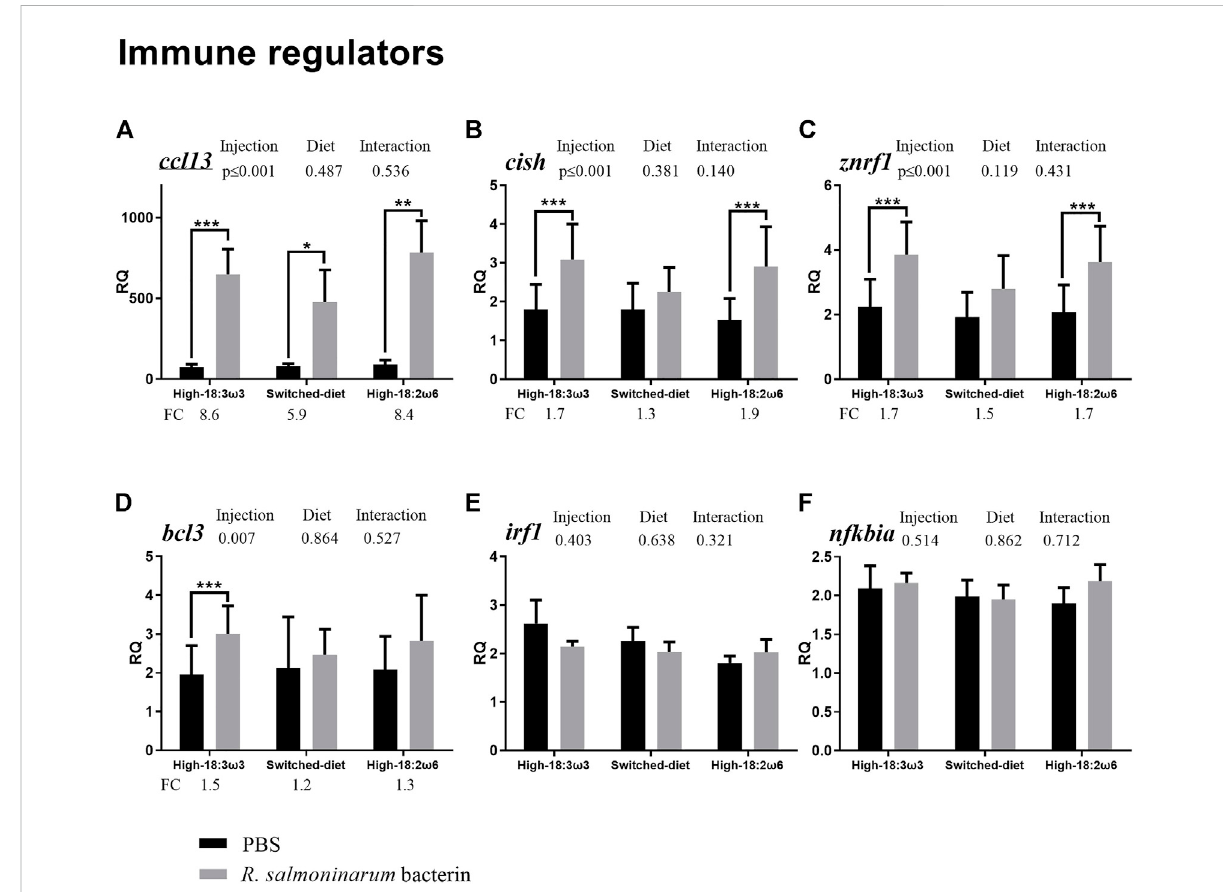
FIGURE 4 qPCR for transcripts representing the immune effectors and transcription factors ( (A – F) ; individual RQs used in the analysis n = 9). Two-way ANOVA results are shown in the table above each panel, and t -test results (i.e., signi fi cant differences between PBS and bacterin-stimulated fi sh within adiet group) are shown with asterisks ( “ * ” for p ≤ 0.05, “ ** ” for p ≤ 0.01,and “ *** ” for p ≤ 0.001). Data arepresented as mean ± SE.Overallfold- change values (FC; mean RQ in bacterin-injected group/mean RQ in PBS-injected group) are shown below the transcripts with signi fi cant differences between groups. The signi fi cance threshold was adjusted to p ≤ 0.05. (A) cc motif chemokine 13 ; (B) cytokine-inducible sh2-containing protein ; (C) e3 ubiquitin-protein ligase znrf1 ; (D) b-cell lymphoma 3 protein-like ; (E) interferon regulatory factor 1 ; (F) nf-kappa-b inhibitor alpha